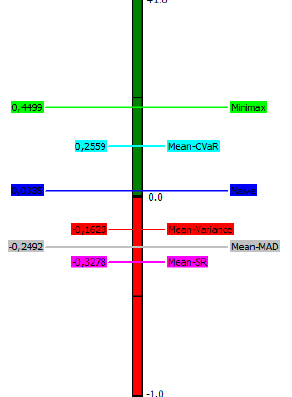
Figure 4. Diagram for Complete Ranking.